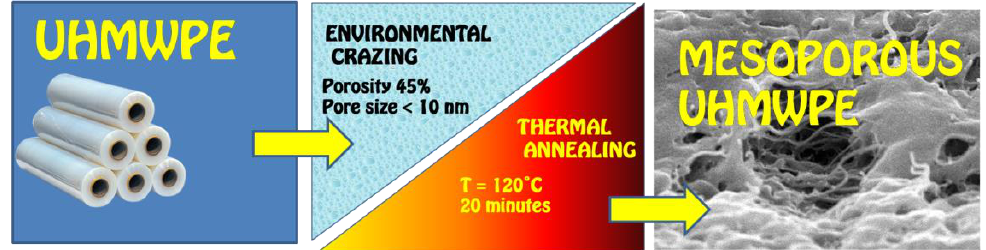
Figure 8. Scheme illustrating the strategy of environmental crazing for the preparation of the mesoporous UHMWPE membrane materials.